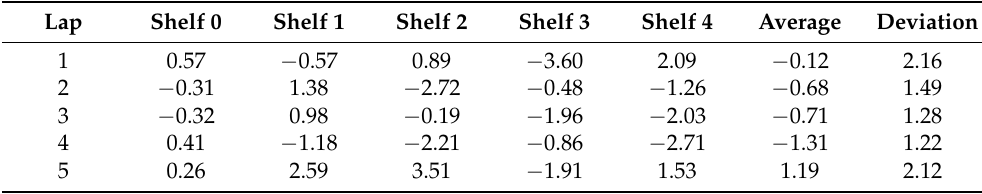
Figure 10. The emulated environment for the first set of experiments: ( a ) actual scene ( b ) simulated scene. Table 1. Position error in X direction (unit: cm).